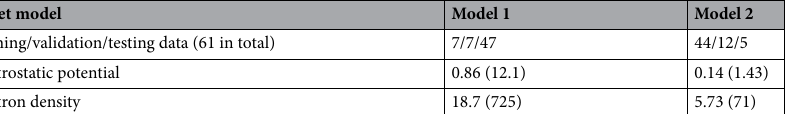
Table 1. Data category and the mean and maximal (in brackets) absolute percentage errors (%) of testing data of the two U-Net models at V GS = 0.29 V.